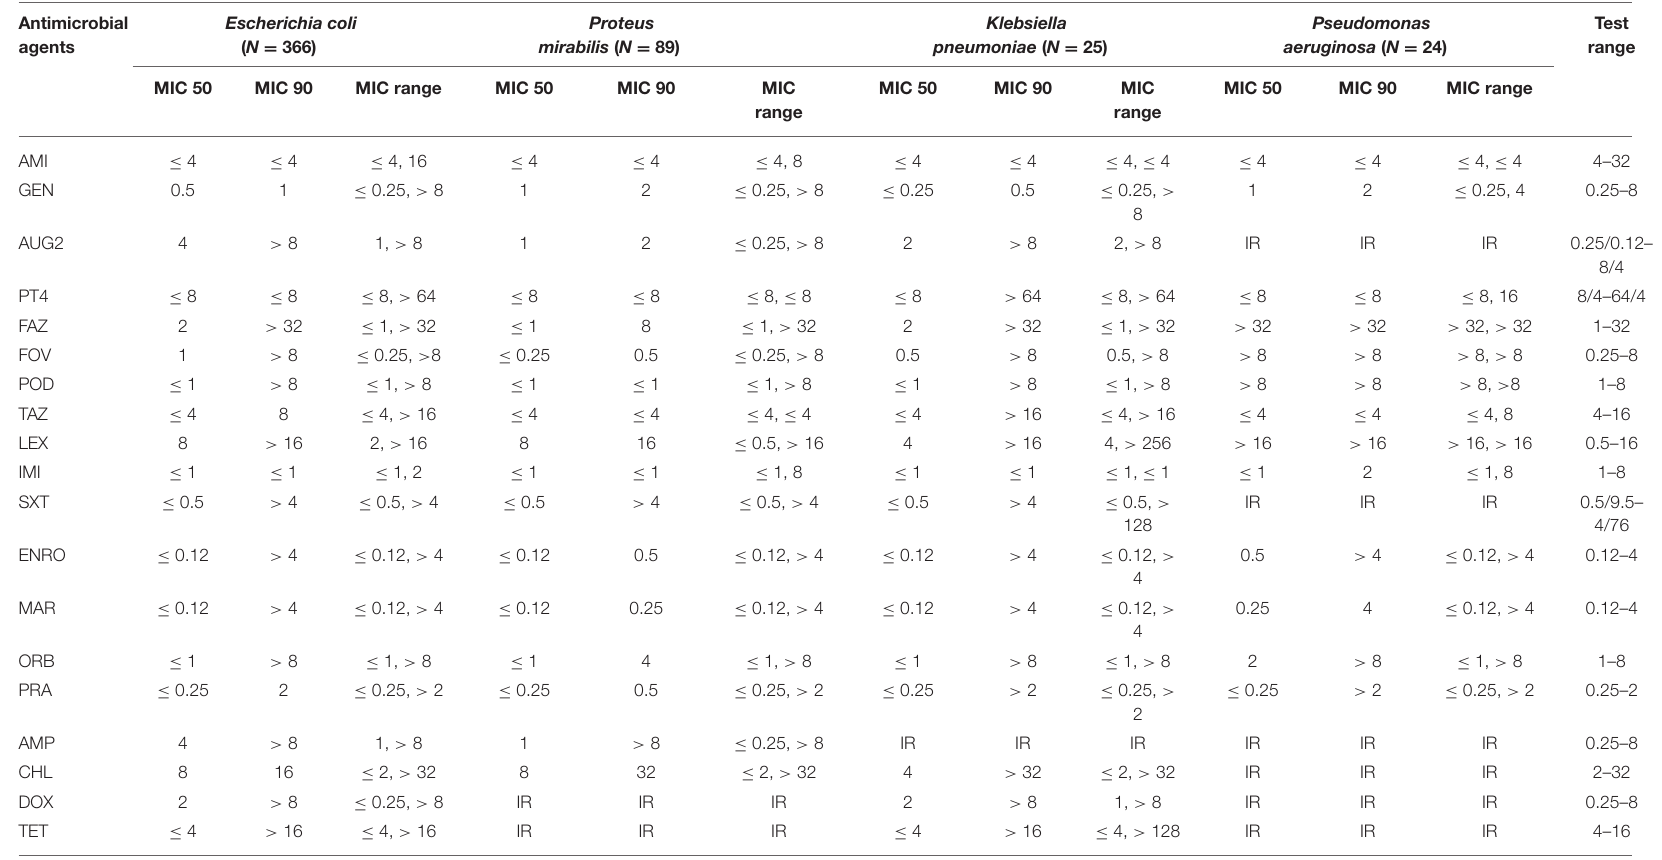
TABLE 5 | The MIC50, MIC90, and MIC range values of the Gram-negative bacterial isolates. Antimicrobial